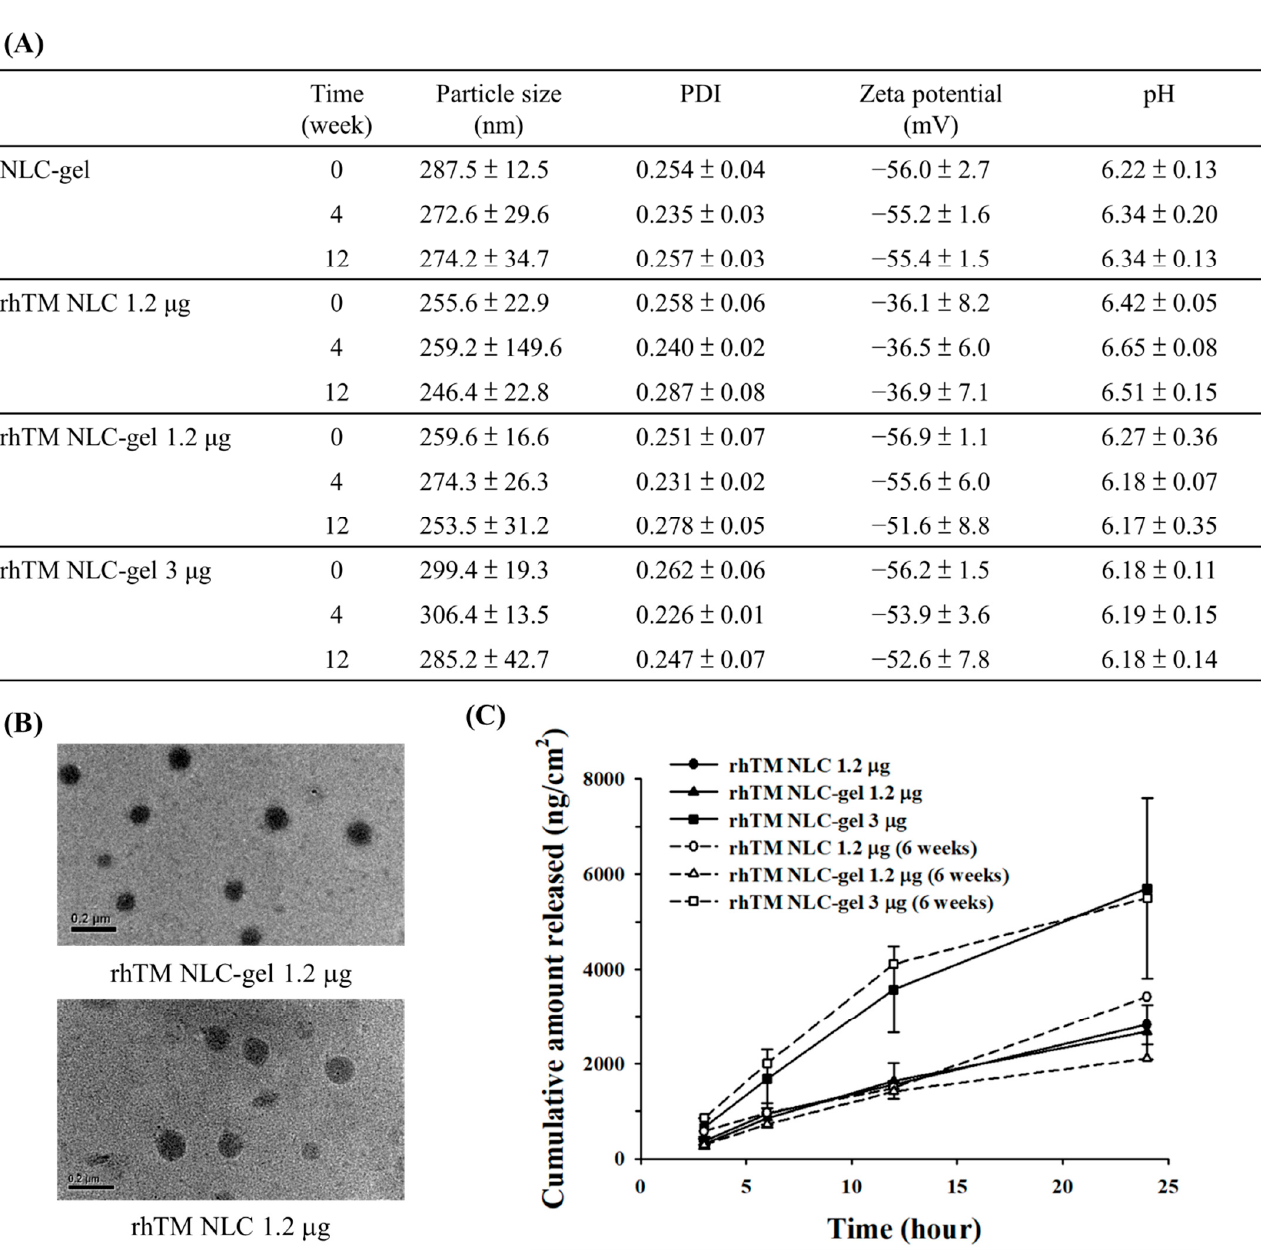
Figure 4. Characteristics and drug release profile of rhTM NLC-gel. ( A ) Physical characteristics of freshly prepared rhTM NLC formulations with and without gel, and after storage at 4 °C for up to 12 weeks. ( n = 3). ( B ) Morphology of rhTM NLC and rhTM NLC-gel particles under TEM. (Scale bar = 0.2 µm). Data presented as mean ± SD. ( C ) In vitro drug release profile of freshly prepared ( n = 4 each) rhTM NLC and rhTM NLC-gel and after storage at 4 °C for 6 weeks ( n = 2 each). Drug release followed dose and time dependent manner.